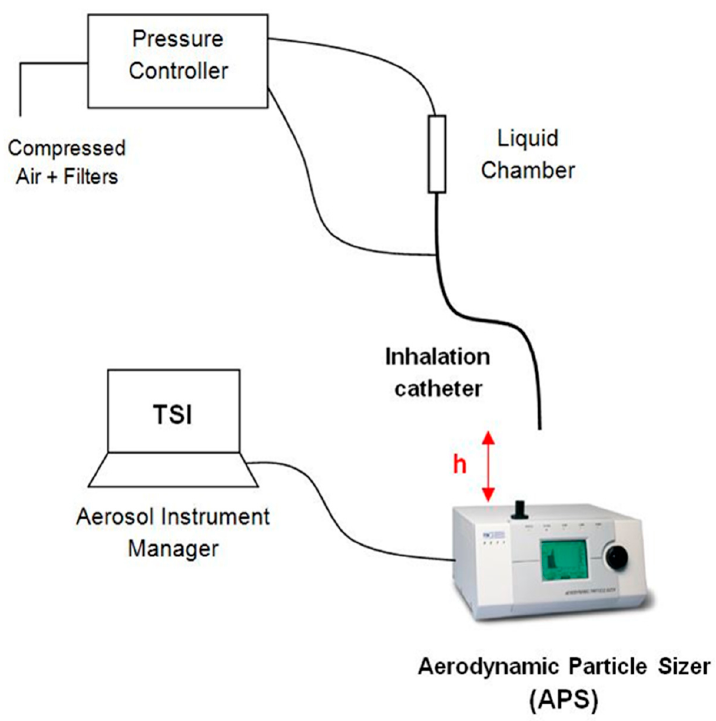
Figure 3. Experimental setup for particle size characterization.